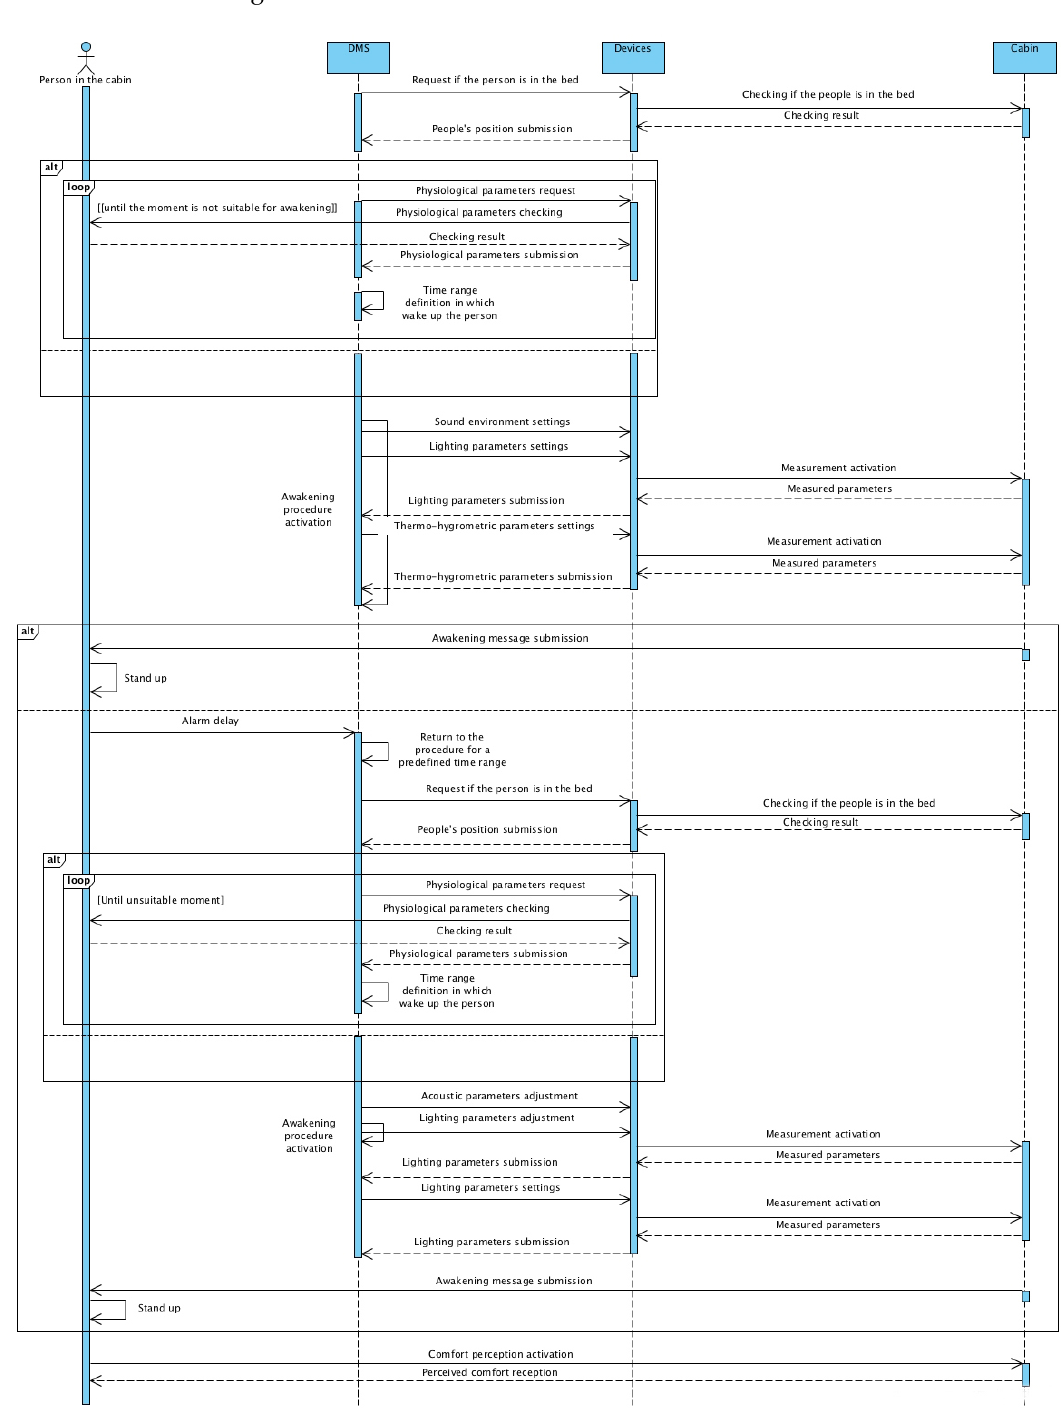
Figure 6. Sequence diagram for the Use Case